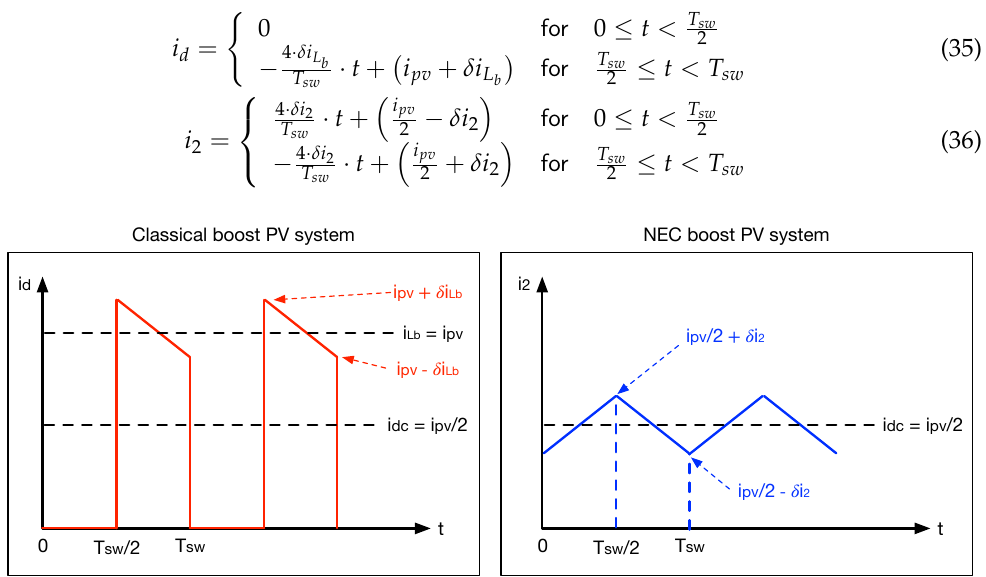
Figure 5. Waveforms of the output currents of classical boost and NEC boost PV systems ( d = 0.5). = 2 · δ i = 2 · δ i = 0.5), the RMS Taking into account that δ i L 2 for this comparison ( d 1 b values for i d (classical boost) and i 2 (NEC boost) are given in (37) and (38),